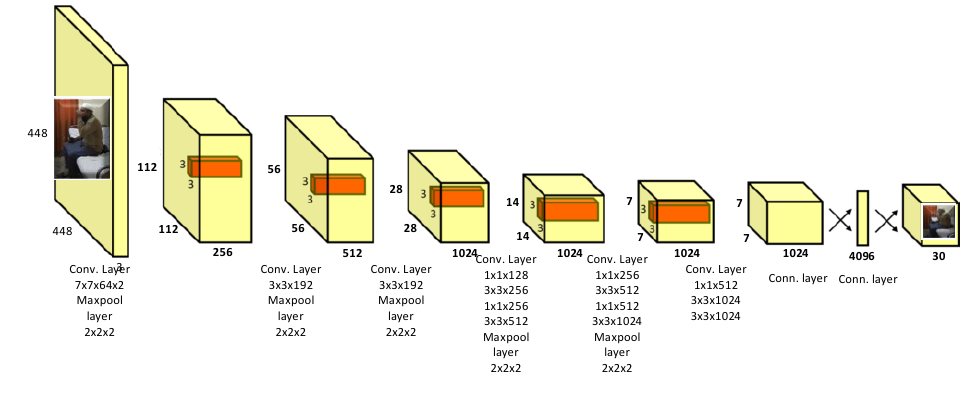
Figure 2. Overall flow of the proposed